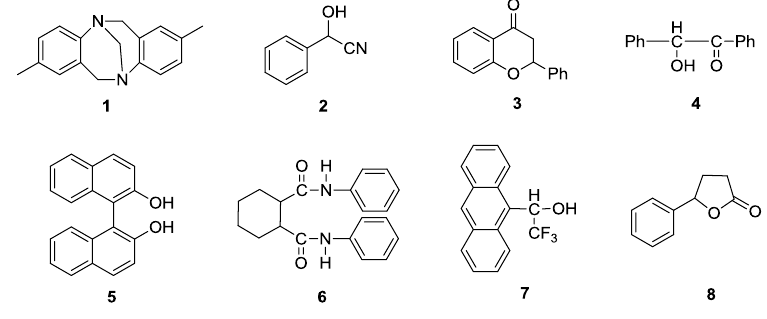
Figure 6. Structures of racemates.